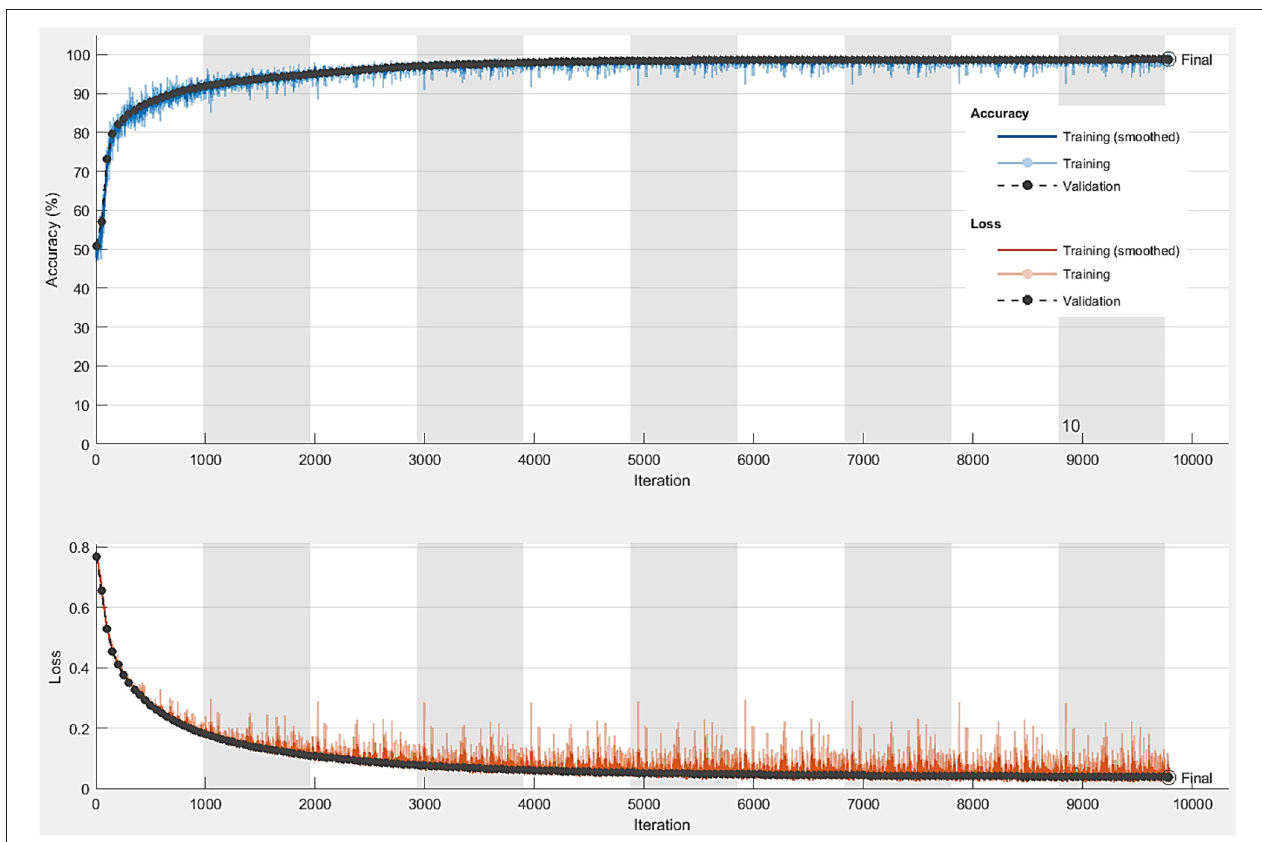
FIGURE 10 | Accuracy and loss graph obtained at the end of training the SegNet network.